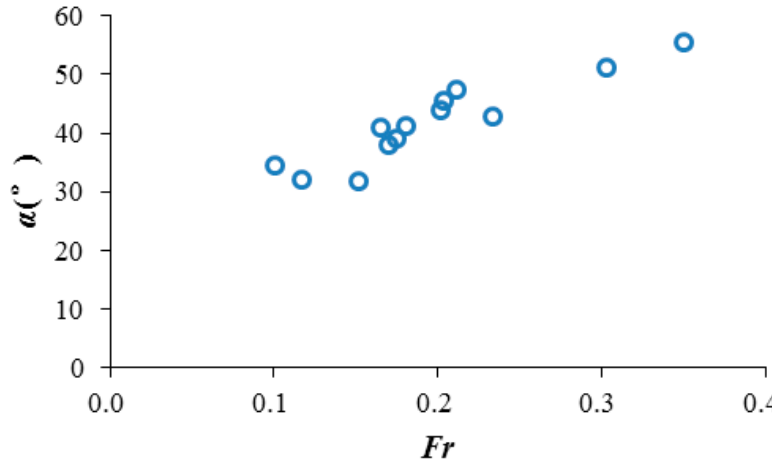
Figure 6. Variation of scour front angle with Froude number.